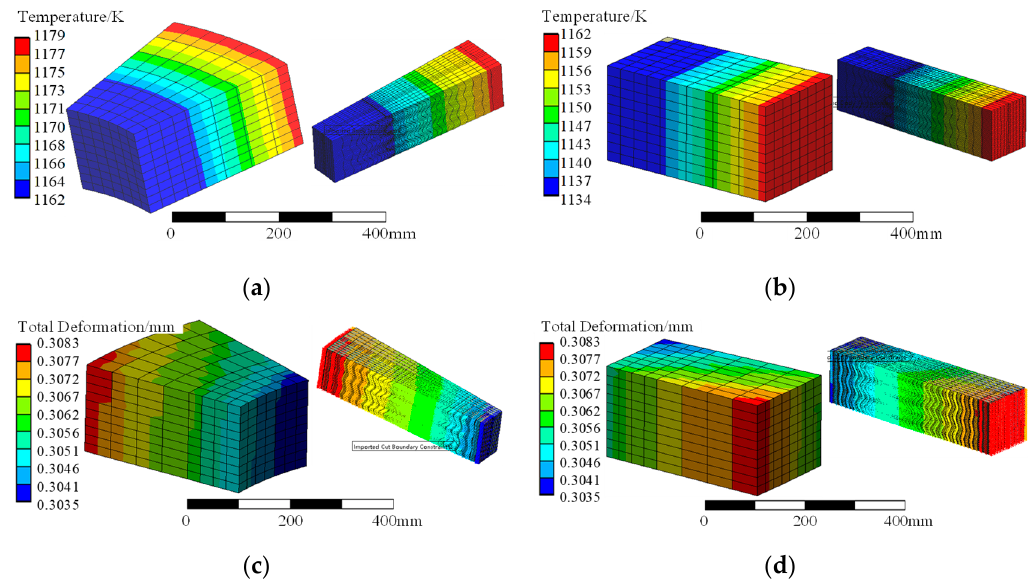
Figure 15. Comparison of parameters before and after importation. ( a ) Temperature in region A; ( b ) Temperature in region B; ( c ) Total deformation in region A; ( d ) Total deformation in region B.